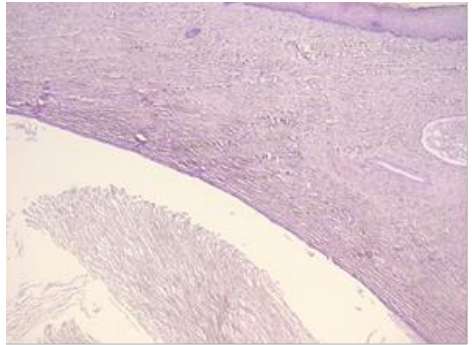
Figure 3. Exo-cervix shows a cystic structure in the deeper layers that is filled with an amorphic, eosinophilic, lamellar substance (HE staining, 5X).